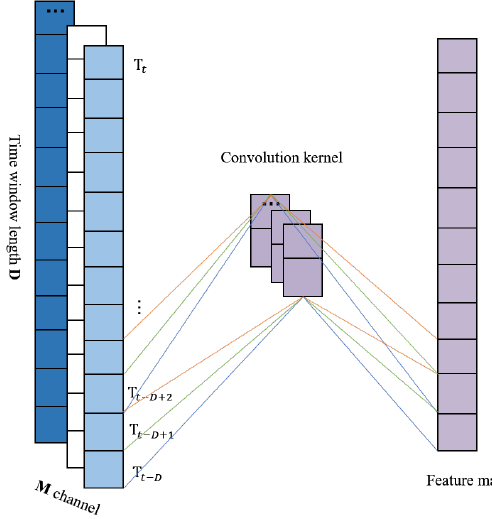
Figure 3. Processing of the M -channel 1 D -convolution operation.